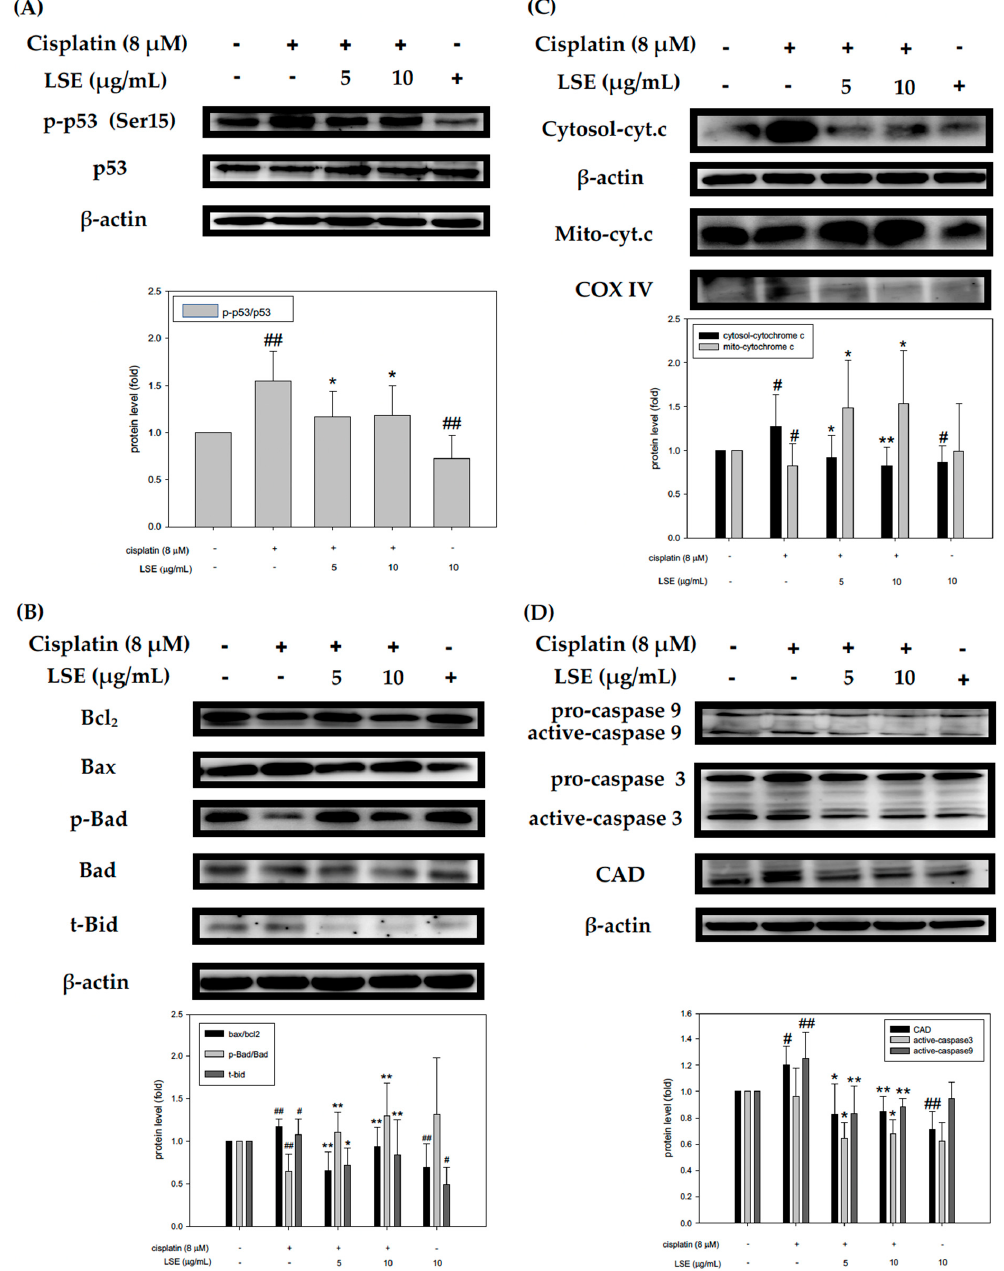
Figure 4. Effect of LSE on cisplatin-induced apoptotic pathway in NRK − 52E cells. NRK − 52E